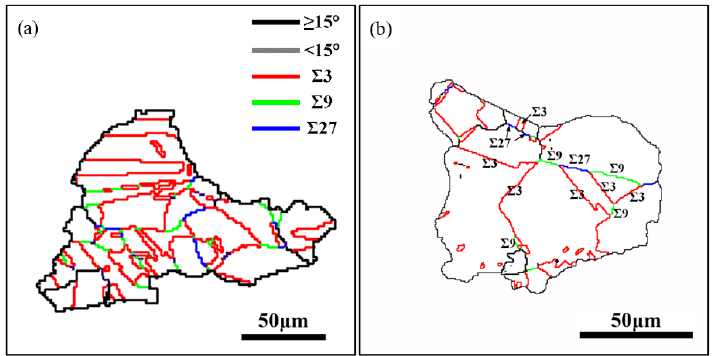
Figure 9. GBCD maps of the twin related domains. ( a ) Domain marked in rectangle in Figure 5c; ( b ) domain marked in rectangle in Figure 5d.